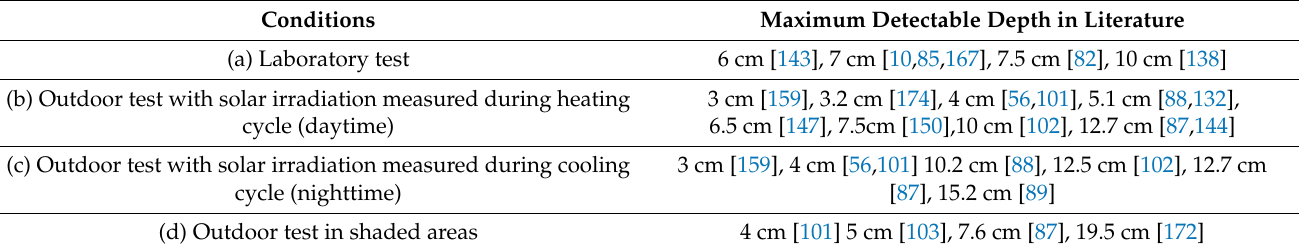
Table 4. Maximum detectable depth in